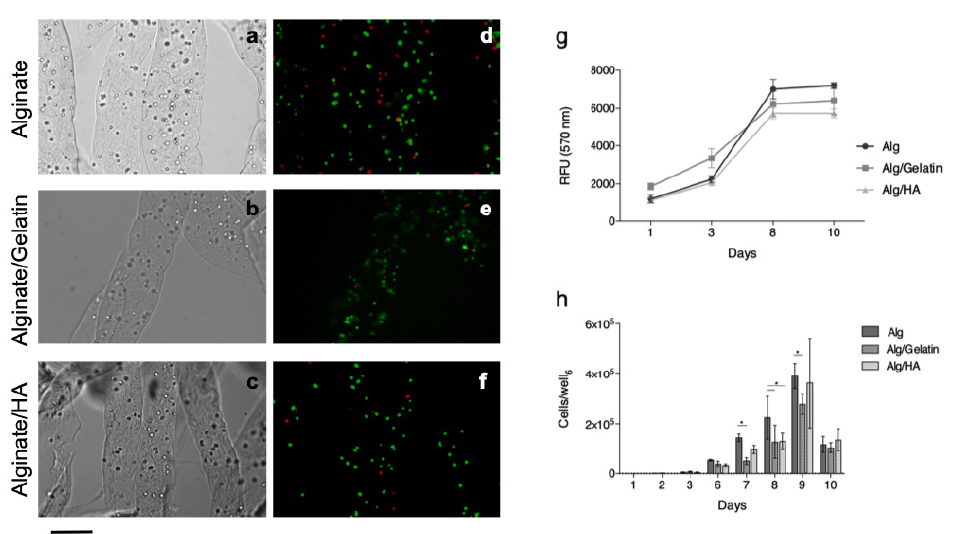
Figure 6. White light ( a – c ) and fluorescence ( d – f ) micrographs of fibroblast-loaded microfibers. Fluorescence images were taken shortly after embedding and staining, with calcein-AM and propidium iodide. Scale bar = 200 µ m. Evaluation of L929 fibroblast behavior after embedding in alginate and blended microfibers: ( g ) Alamar Blue ® fluorescence intensities and ( h ) the number of cells released from the microfibers.